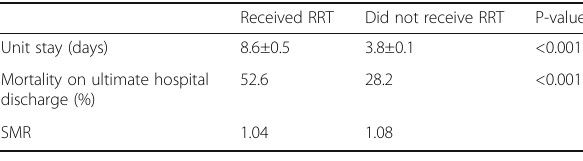
Table 40 (abstract A103). Outcomes